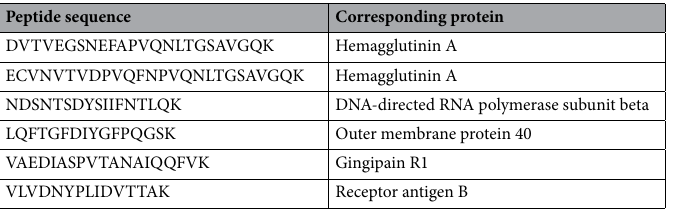
Table 5. Distinct peptides of Porphyromonas gingivalis ( Pg ) derived from the feces of Pg -treated and CMC- treated db / db mice using proteome